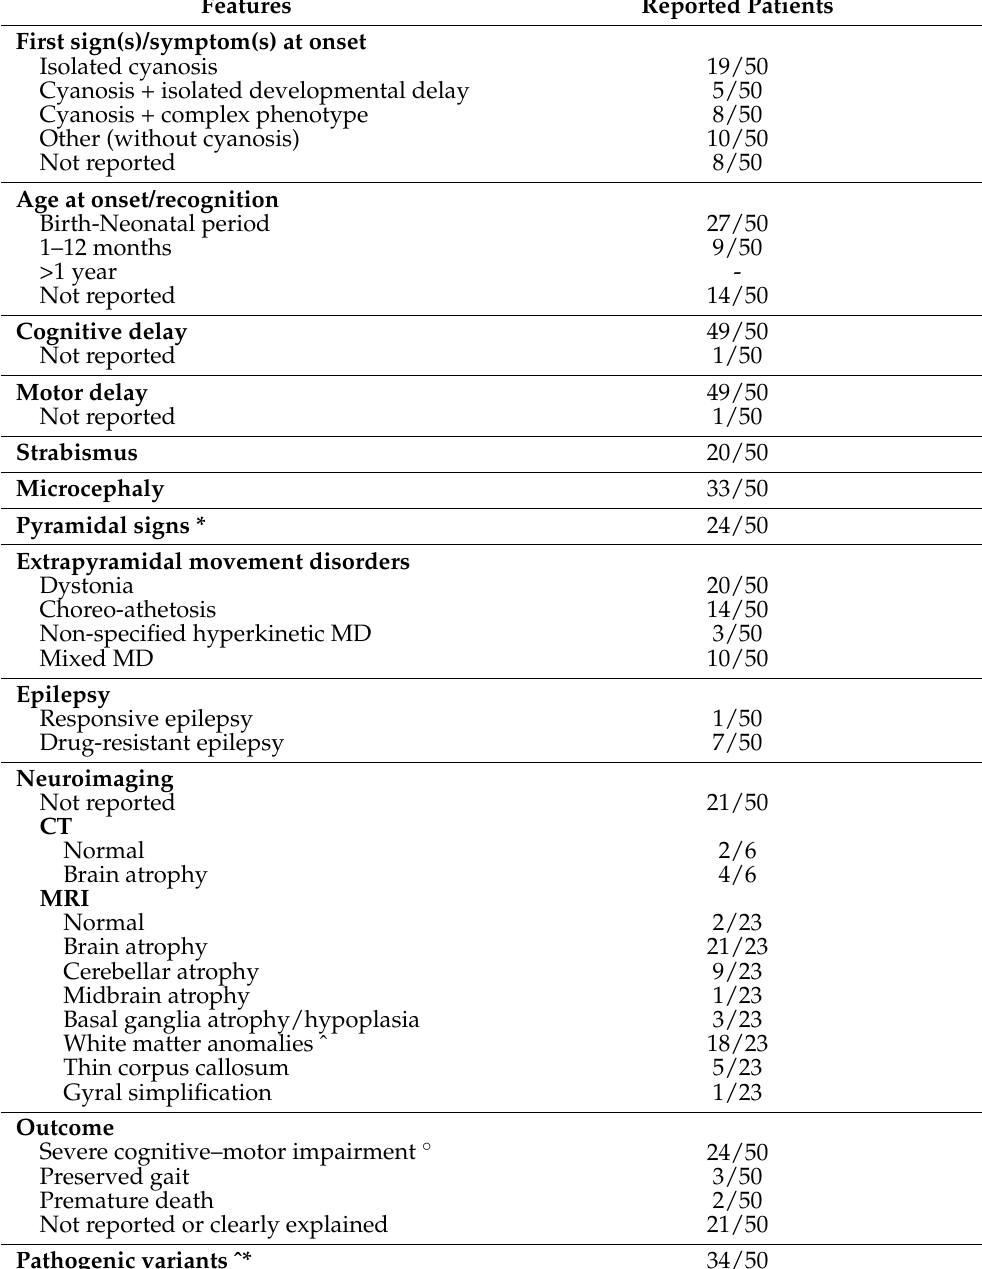
Table 1. Revision of the main features of the 50 patients with RHM2 (forty-nine patients from thirty-one available literature articles plus our